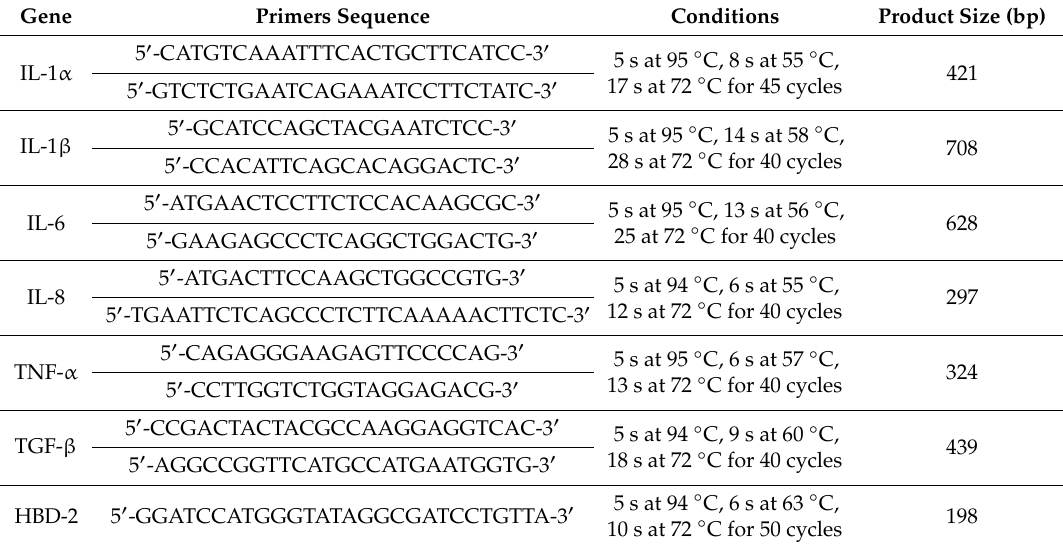
Table 1. qRT-PCR parameters utilized to analyze the immunomodulatory properties of the material. The table indicates the gene analyzed, the primer sequences, operational conditions, and product